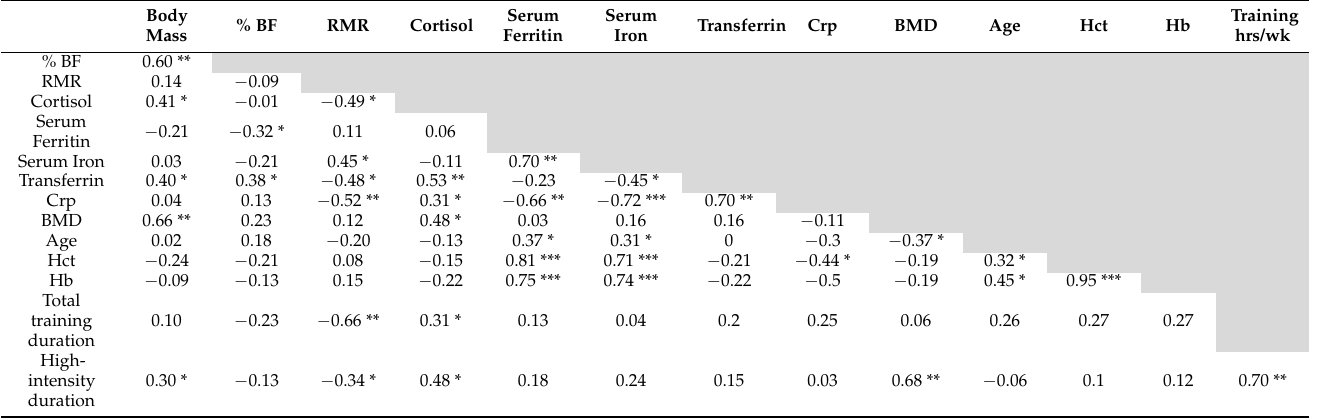
Table 3. Pearson’s correlations between measured blood markers, resting metabolic rate (RMR), and bone mineral density (BMD) in highly trained, non-professional female